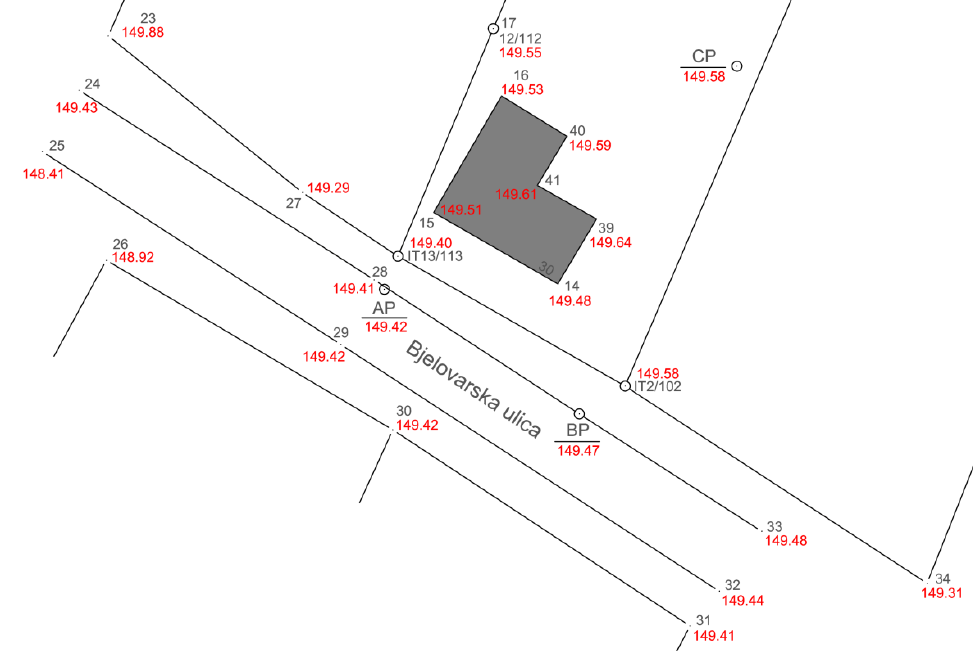
Figure 11. Geodetic situational draft – a part (URL